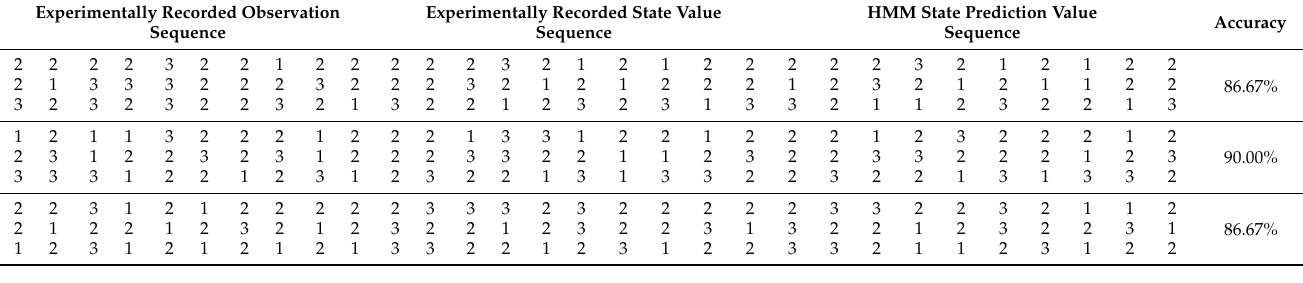
Table 2. Validation results for vigilance assessment using hidden Markov model.